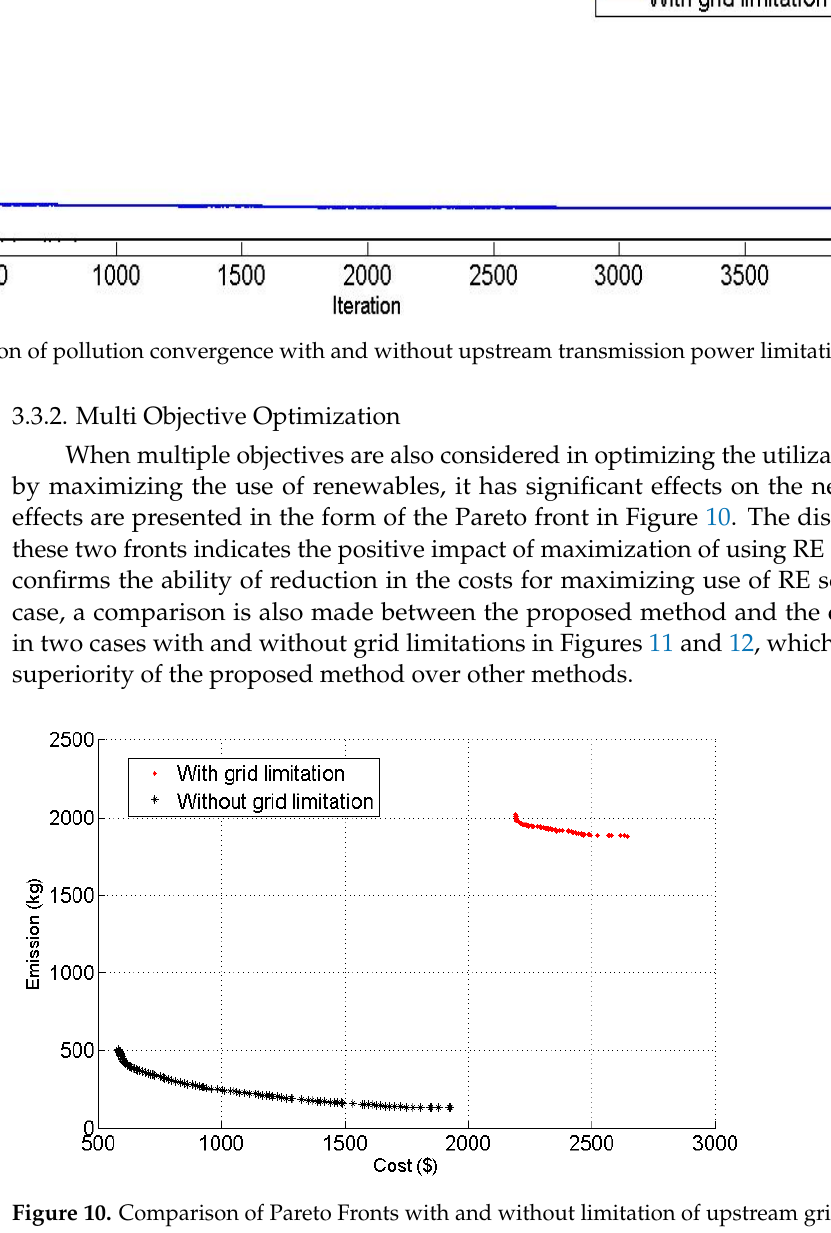
Figure 11. Results of implementing different methods considering the limitations of upstream grid power exchange (cost and emission based). Figure 12. The results of implementing different methods without considering the limitations of upstream power exchange (cost and emission based). 3.4. Sensitivity Analysis In order to show the sensitivity, the algorithm has been implemented to solve the issue of optimal number of populations in the problem of optimal operation of MG with